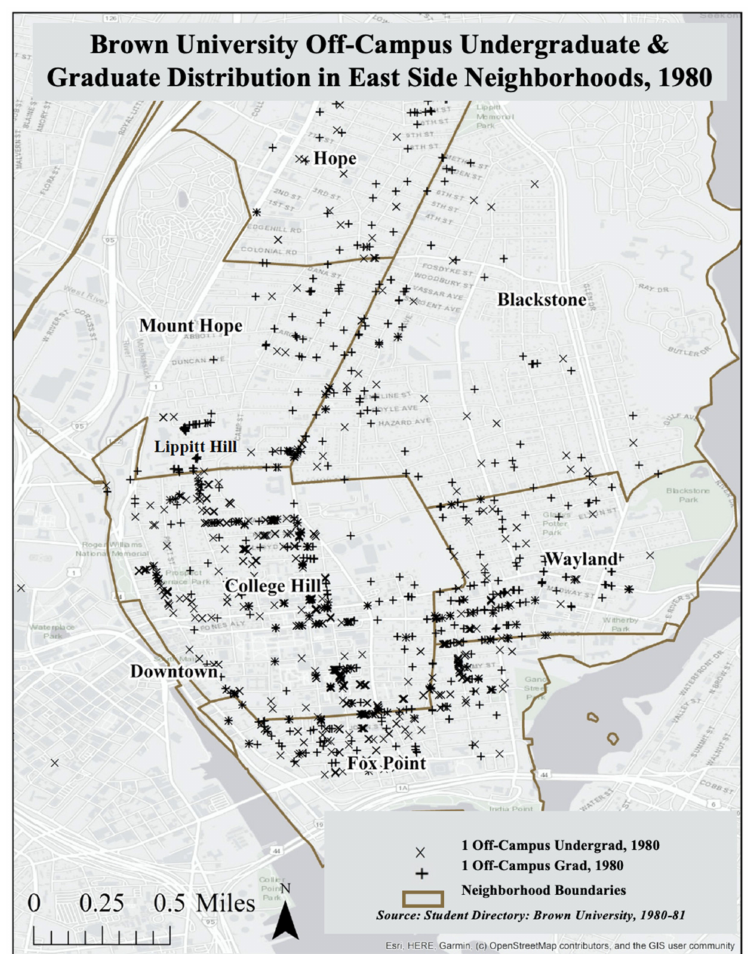
Figure 6. Brown University o ff -campus undergraduate and graduate distribution in East Side neighborhoods, 1980. In 1980, 1178 undergraduates lived at Providence o ff -campus addresses. This constituted 22% of the undergraduate population. The percent o ff -campus is inclusive of all undergraduates with a Providence address (including some in neighborhoods beyond the East Side) and calculated using historical enrollment data; 718 graduate students lived at Providence o ff -campus